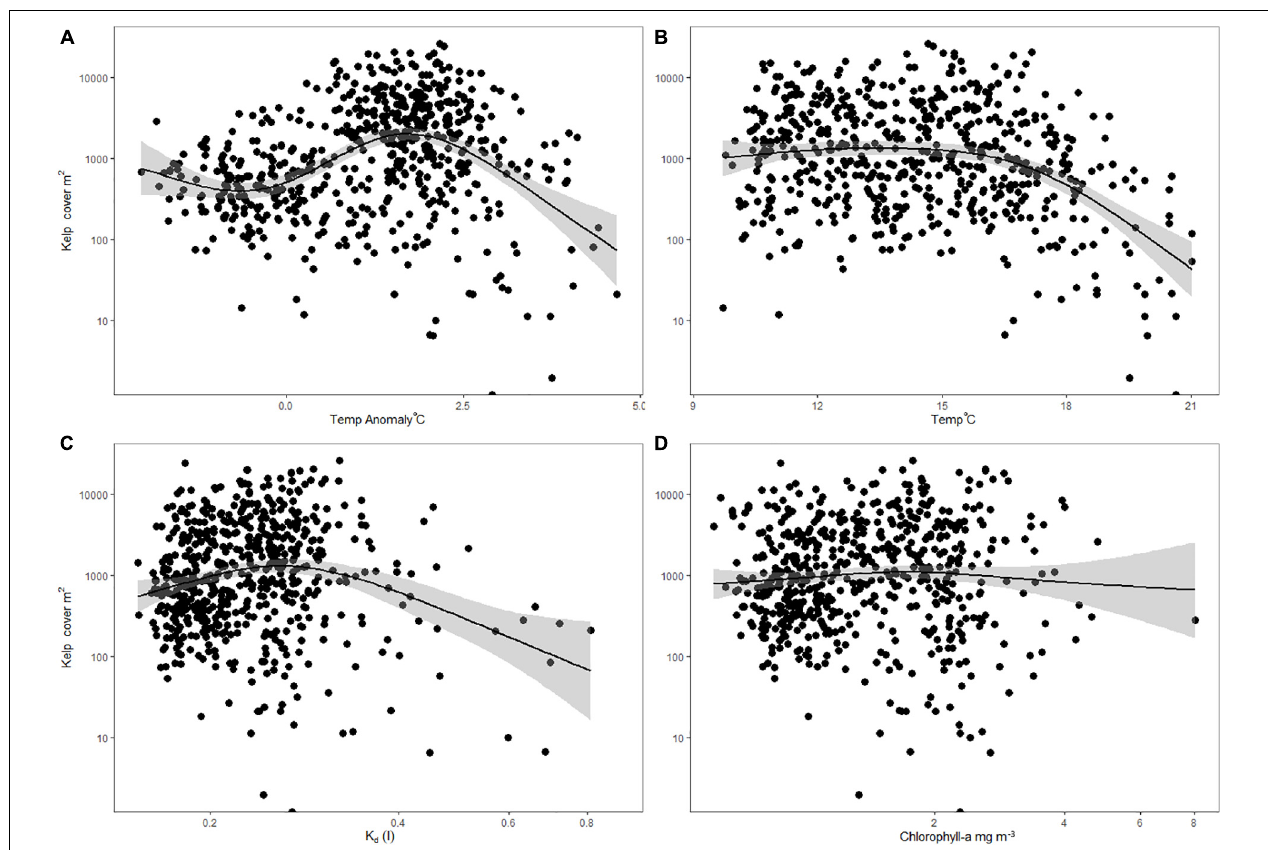
FIGURE 5 | Macrocystis surface canopy cover as related to mean monthly temperature anomaly (A) , maximum monthly temperature (B) , water clarity- K d (C) , and chl- a concentrations (D) , combined across all regions. Y-axis are log transformed. Relationships are fitted by GAM with standard